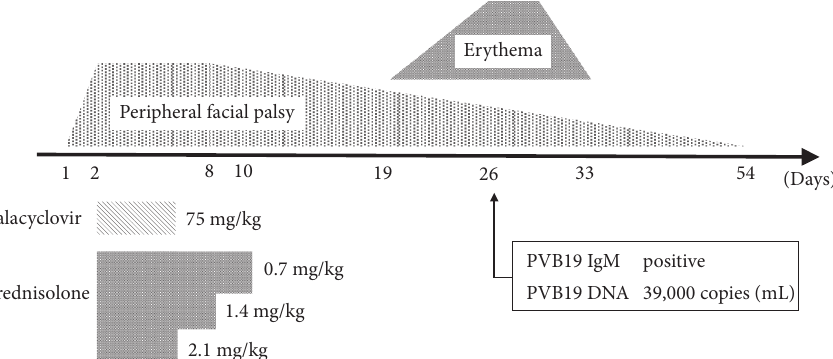
Figure 1: Treatment with valacyclovir and prednisolone started on the second day of peripheral facial palsy. The erythema appeared approximately 3 weeks after peripheral facial palsy was first indicated. PVB19-specific serum IgM was positive and PVB19 DNA was detected in the serum by real-time quantitative PCR on the 26th day. Remission of erythema and peripheral facial palsy were confirmed on the 37th day and 54th day,